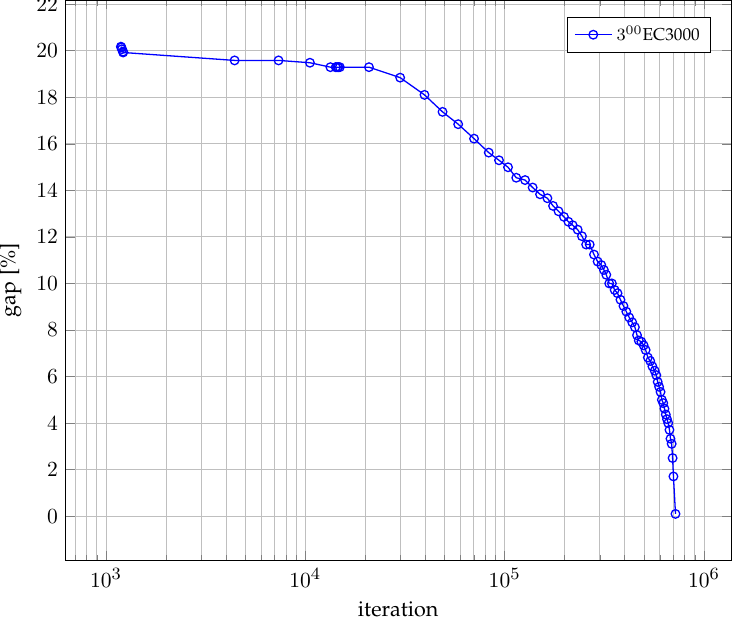
Figure 10. Convergence of the MIP method.